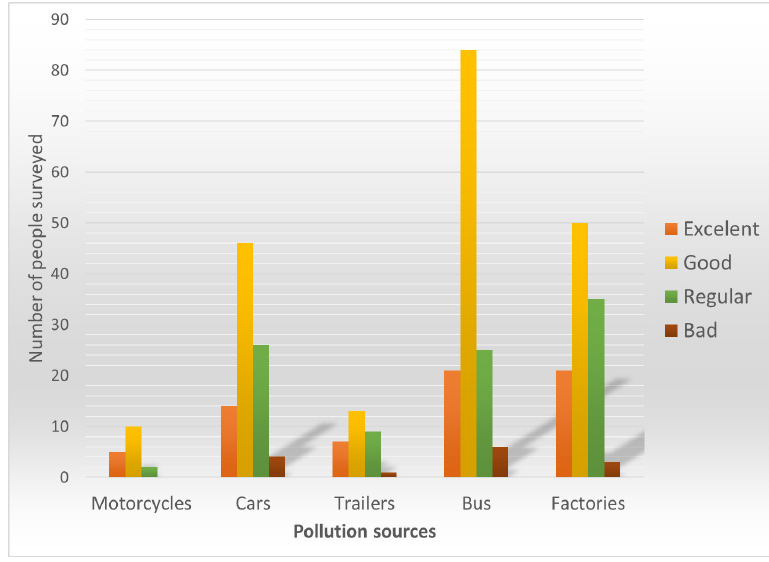
Figure 10. What do you think causes pollution (by general health)?